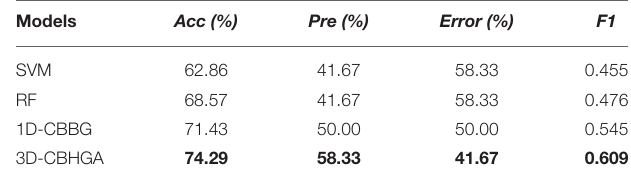
TABLE 2 | Dataset sample distribution. TABLE 3 | Performance of different models on DAIC-ori.